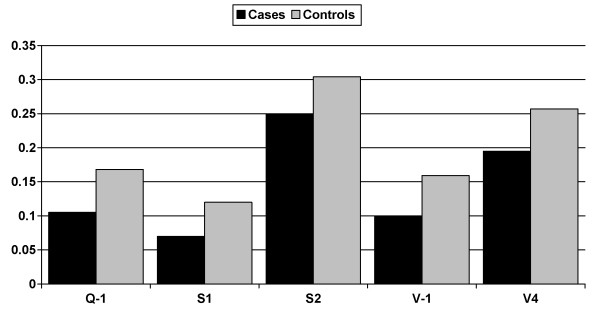
Minor allele frequency of SNPs in ADAM33 that were statistically significantly* different between COPD† cases and controls. *p value < 0.05. SNPs S2 and V4 were not significant after banferroni correction. †COPD: Chronic Obstructive Pulmonary Disease; defined by defined by an FEV1/FVC ratio < 70% and ppFEV1 < 75% (n = 287). Control group were smokers with an FEV1/FVC ratio ≥ 70% and ppFEV1 ≥ 80% (n = 311).